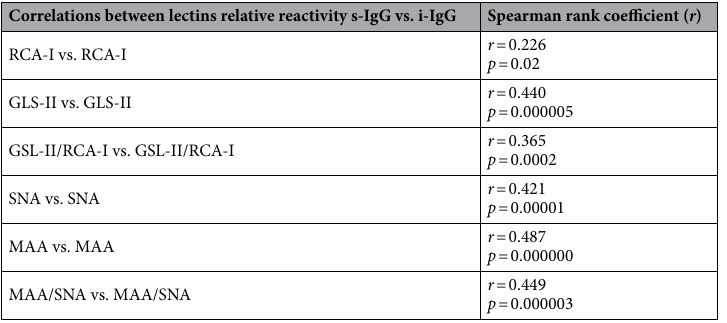
Table 3. The correlations between relative reactivities of s-IgG and i-IgG glycans with lectins. Serum native IgG—s-IgG; serum IgG isolates—i-IgG. GSL-II: Griffonia simplicifolia lectin II, recognizing terminal GlcNAc; RCA-I: Ricinus communis agglutinin I, recognizing terminal Gal; MAA: Maackia amurensis agglutinin, recognizing sialic acid α2,3-linked; SNA: Sambucus nigra agglutinin, recognizing sialic acid α2,6-linked. A two-tailed p -value of less than 0.05 was considered as